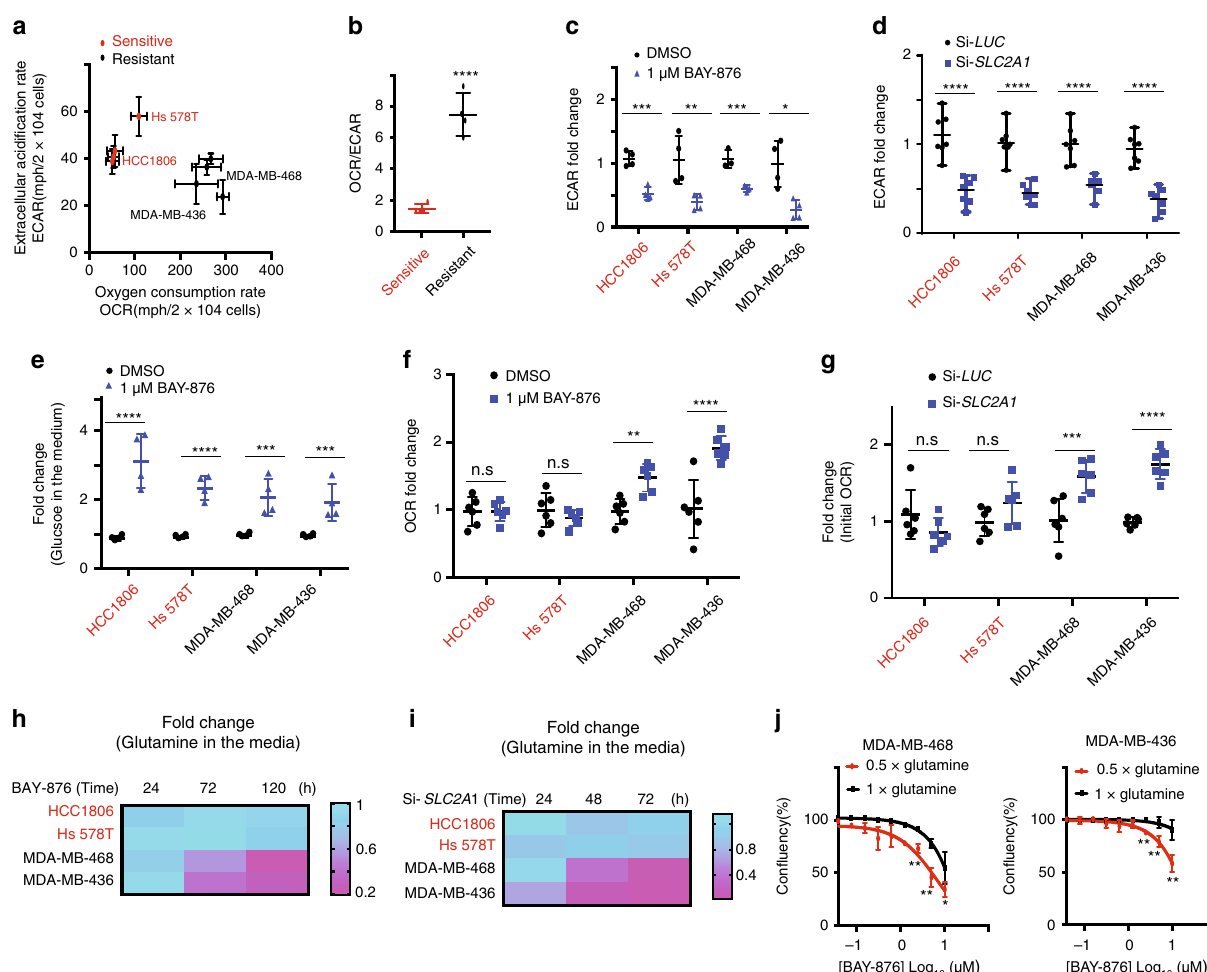
Fig. 2 OXPHOS levels correlate with the response to GLUT1 inhibition. a OCR and ECAR were measured for each of BAY-876-sensitive lines (red) and resistant lines (black). b OCR and ECAR ratio were calculated for each cell line. Student ’ s t test, **** p < 0.0001. c ECAR values measurement of cells with or without BAY-876 treatment for 5 days. n = 4; mean ± s.d.; Two-way ANOVA. * p < 0.05; ** p < 0.01; *** p < 0.001. d ECAR values measurement of cells with siRNA of GLUT1 knockdown or luciferase control. n = 7; mean ± s.d. Two-way ANOVA. **** p < 0.0001. e Glucose uptake analysis were performed in cells following BAY-876 treatment for the 5 days. n = 4; mean ± s.d. Two-way ANOVA. *** p < 0.001; **** p < 0.0001; f A trace of OCR values from a mitochondrial stress test of cells with or without BAY-876 treatment for 5 days. n = 4; mean ± s.d. Two-way ANOVA. **** p < 0.0001; n.s. not signi fi cant. g A trace of OCR values from a mitochondrial stress test of cells with siRNA of GLUT1 or luciferase control. n = 6; mean ± s.d. Two-way ANOVA. *** p < 0.001; **** p < 0.0001; n.s. not signi fi cant. h Glutamine uptake analysis was performed in cells following 1 μ M BAY-876 treatment. n = 3. i Glutamine uptake analysis performed in cells transfected with 25 nM si SLC2A1 (bottom). n = 2. j Growth curves of MDA-MB-468 cells (left) and MDA-MB-436 cells